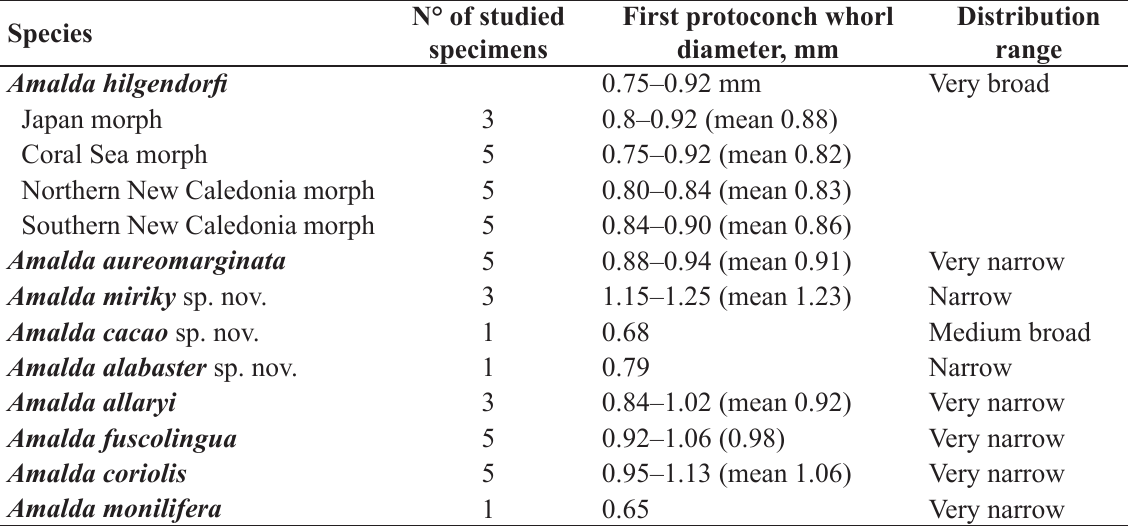
Table 2. Size of the protoconchs of the studied